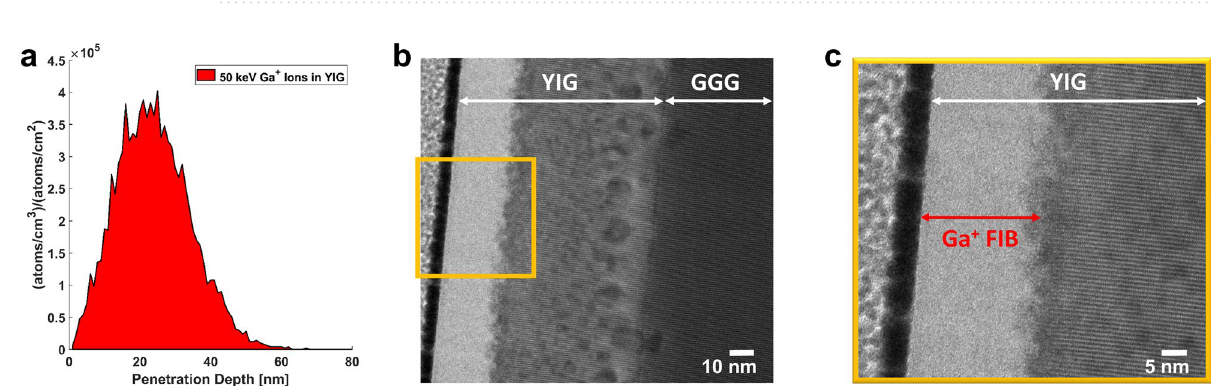
Figure 5. Crystal investigation of the FIB impact in YIG by means of TEM. ( a ) Shows the simulated ion implantation depth for 50 keV Ga + ions in Y 3 Fe 5 O 12 . A cross-sectional image of a 80 nm thick irradiated YIG film is depicted in ( b ). ( c ) The magnification of the orange square in ( b ) exposes an amorphous toplayer of the thickness expected from the SRIM simulations in ( a